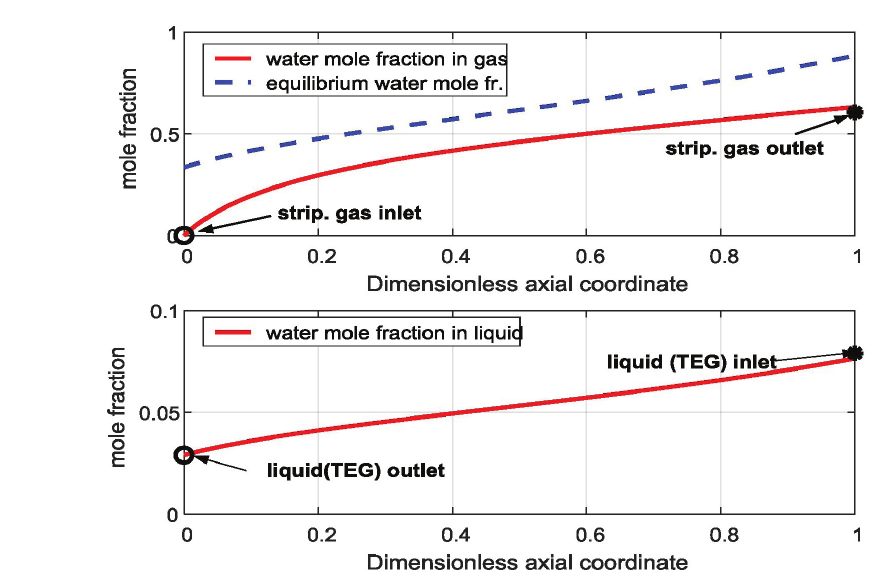
Fig. 10 – Water mole fraction profiles for the operating parameters from Table 2 (K